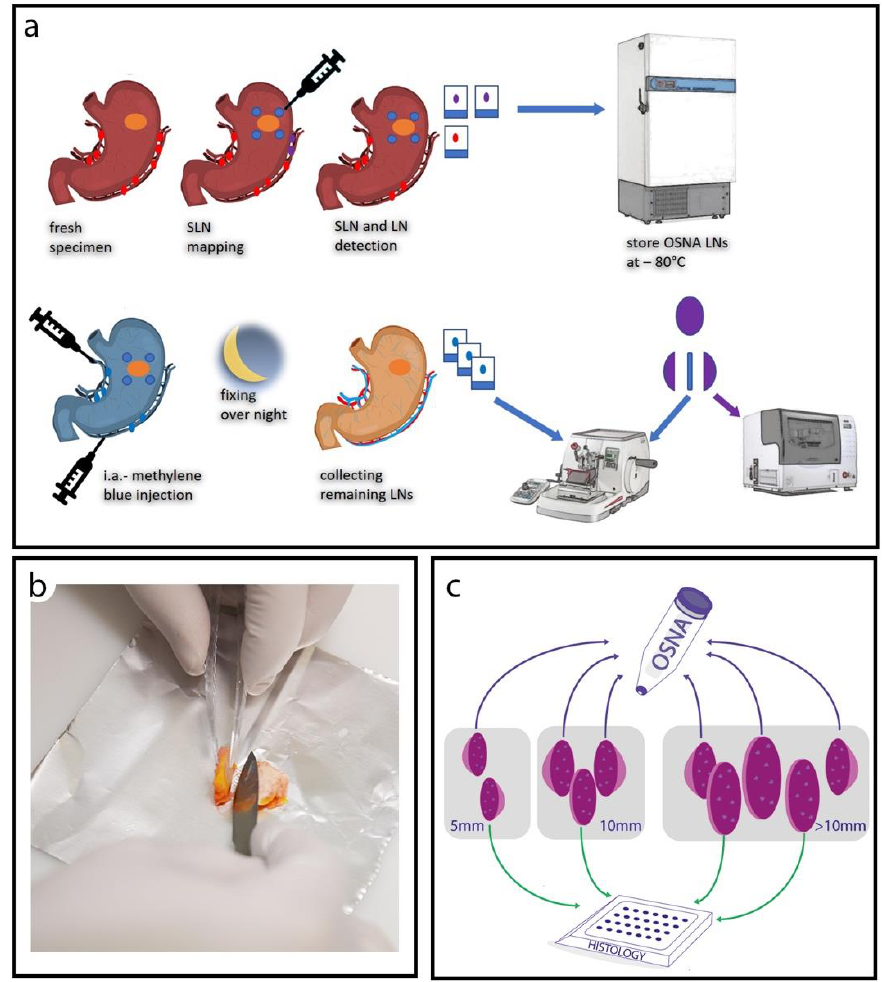
Figure 1. Tissue processing. ( a ) Specimen processing with SLN mapping and dissection of lymph nodes in the fresh state for mRNA-analysis. After completion, intra-arterial injection of methylene blue solution. After fixing LNs overnight, a second dissection of lymph nodes for the histological workup is performed. ( b ) Slicing of a frozen lymph node for the distribution between molecular and histological evaluation. ( c ) Scheme of tissue partitioning: small LNs of up to 5 mm short diameter were bisected, and half of the node was processed for histological evaluation, while the remaining half was used for OSNA analysis. In intermediated-sized LNs, between 5 to 10 mm, a middle slice of about 2 mm thickness was cut out for the histology, and the remaining parts of the node processed by OSNA. In large LNs (>10 mm), at least two slices were cut out for histology, while the rest was analyzed by